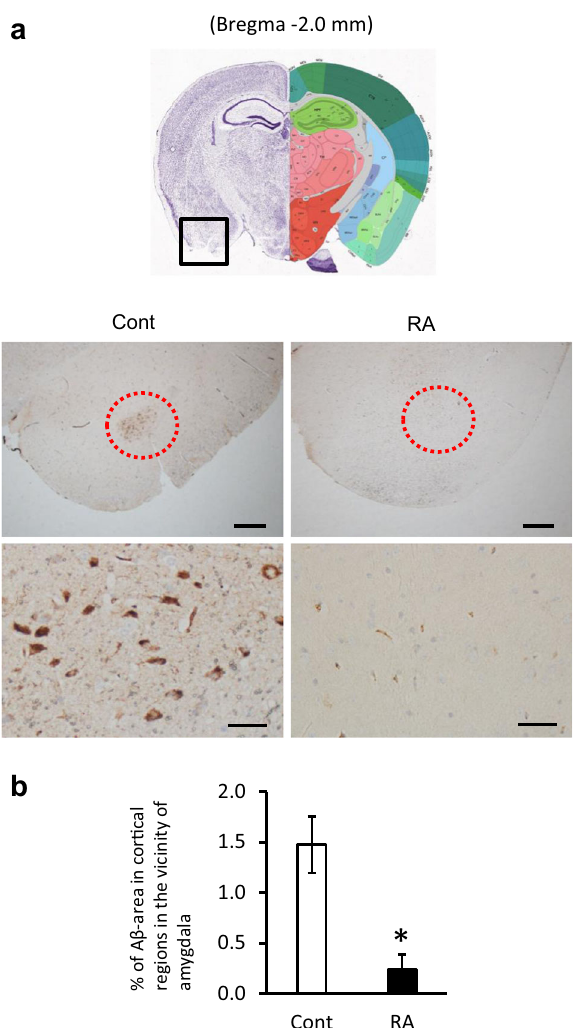
Fig. 2 Suppression of A β accumulation in Alzheimer ’ s disease pathology by RA intake. Paraf fi n sections were stained with anti-A β (4G8) and peroxidase-based labeling (brown) and counterstained with hematoxylin to visualize nuclei (violet). a In the RA group, A β accumulation was reduced in cortical regions in the vicinity of the amygdala. Images in bottom are the magni fi ed view of the red circle in the upper fi gure. The scale bars in upper and lower showed 500 and 50 μ m in distance, respectively. b A β plaque area per 1000 μ m 2 of cortical regions in the vicinity of the amygdala. Data are shown as means ± standard error. Cont, n = 3; RA, n = 3; * p < 0.05.